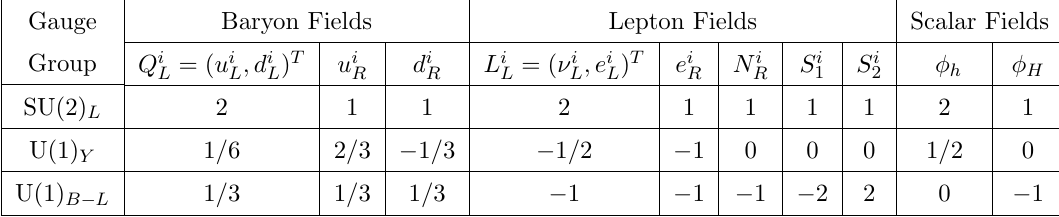
Table 1 . Complete particle spectrum and their corresponding charges under various gauge